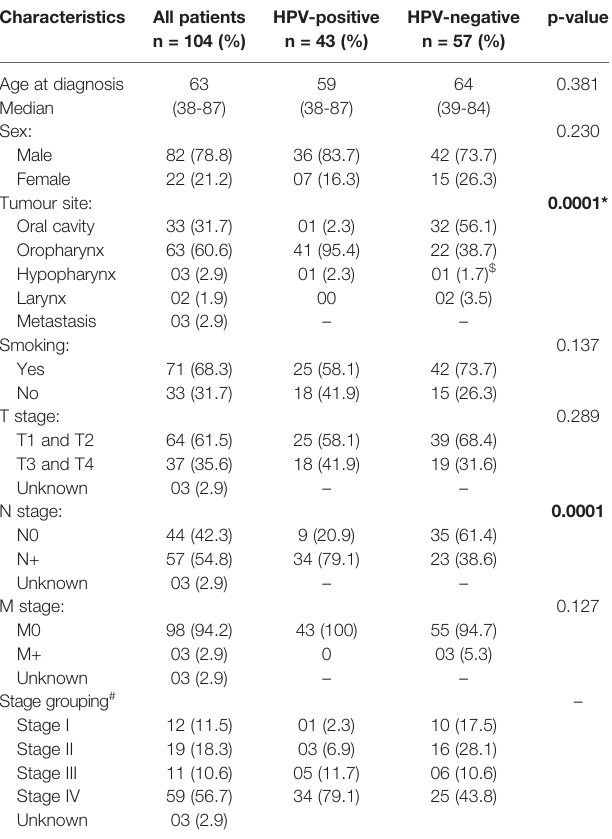
TABLE 1 | Clinical parameters of patients.